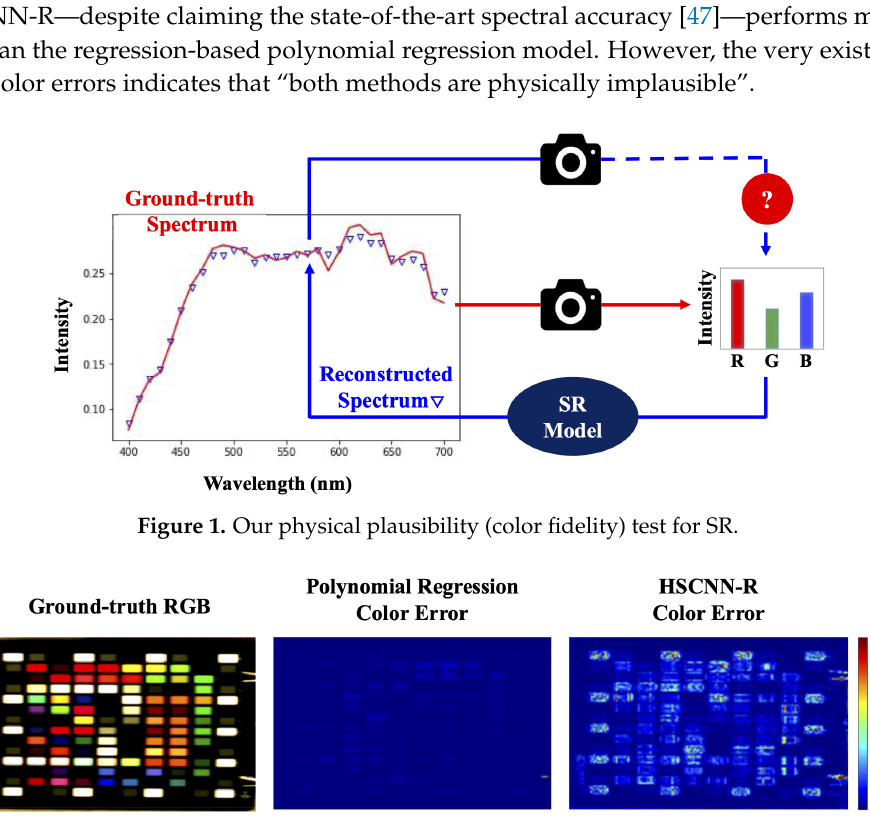
Figure 2. The color errors introduced by polynomial regression SR [34] ( left ) and HSCNN-R [46] ( right ). The color errors are measured in CIE ∆ E 2000 ( ∆ E 00 )